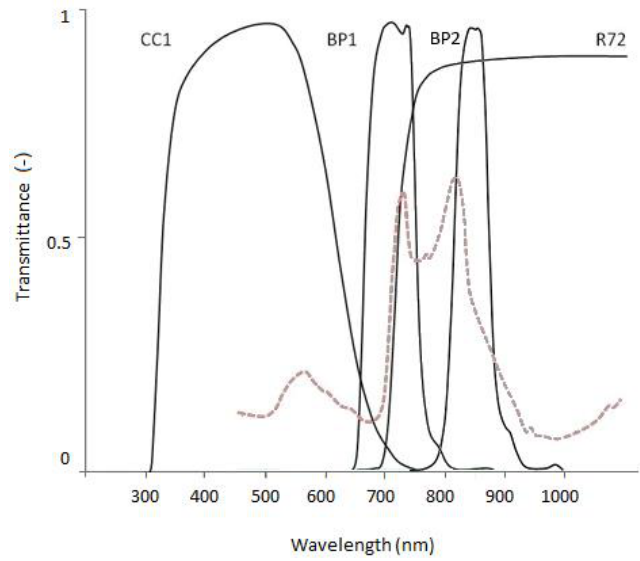
Figure 2. Transmission spectra of BP1 and BP2 bandpass filters and CC1 and R72 blocking filters based on manufacturers specifications (maxmax.com). Submerged macrophyte spectrum included with dashed red line for comparison. Table 2. Specifications of lens filters used to obtain a six-band multi-spectral